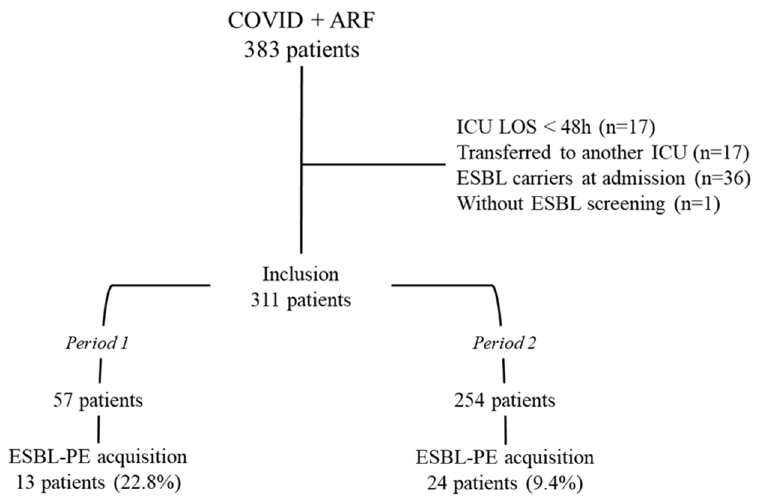
Figure 1. The flow-chart of the study. ARF: Acute respiratory failure, ICU LOS: Intensive care unit length of stay.